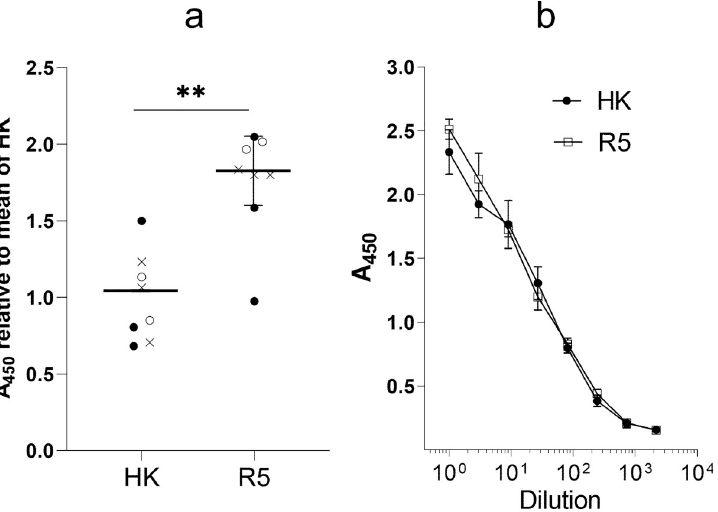
Fig 5. Attachment of HK and R5 to cells in HTBE cultures. ( a ) The apical sides of live HTBE cultures were washed with PBS+ to remove accumulated mucins and inoculated with 0.2 ml of DMEM-BSA containing 1.3x10 6 FFU of HK and R5. Control cultures were inoculated with DMEM-BSA. After 1-h incubation at 4˚C the cultures were washed, fixed and immune-stained using anti-HK primary antibodies and HRP-labelled secondary antibodies. The mean absorbance in the control cultures was subtracted, and the results were expressed as the relative absorbance at 450 nm (A 450 ) in R5-treated and HK-treated cultures with respect to the mean absorbance in the latter. Open circles, closed circles and crosses depict individual data points from three experiments performed on different days. Mean, SD and P values were calculated using within-day averages. ( b ) Control of the concentrations of physical viral particles in suspensions of HK and R5 used for the HTBE attachment experiments. Suspensions were serially diluted in PBS and adsorbed in the wells of ELISA microplates. The wells were washed, fixed and immuno-stained as described above. Shown are the results of one experiment with 5 replicates per condition. The absorbance (A 450 ) reflects non-specific binding of HK and R5 to the plastic. Overlap of the A 450 vs dilution curves indicate that suspensions used in the Fig 5a contained equal amounts of viral